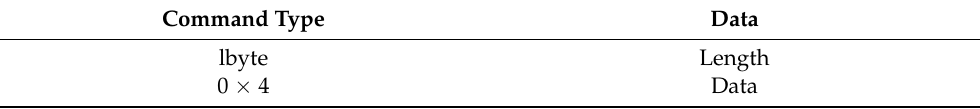
Table 4. Client data query returns data packet.